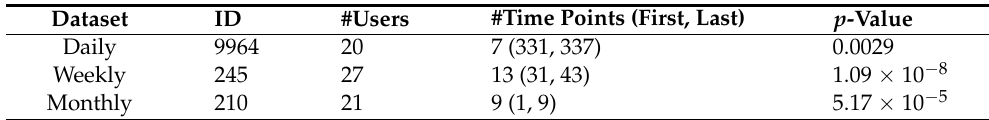
Table 3. Constant biclusters picked for each of the